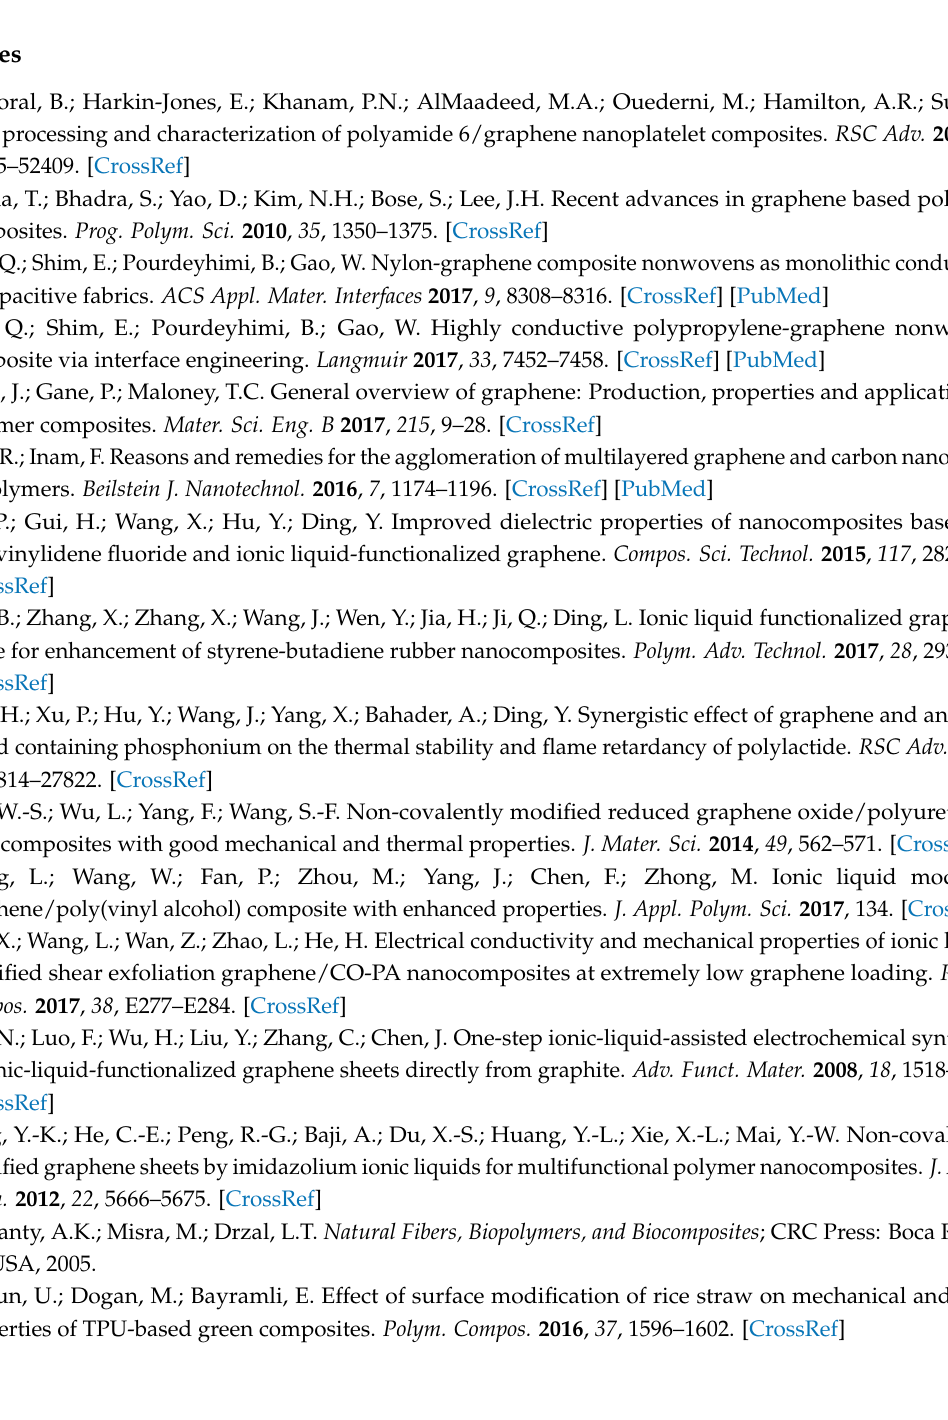
Table S1: Young’s modulus of the bTPU/IL